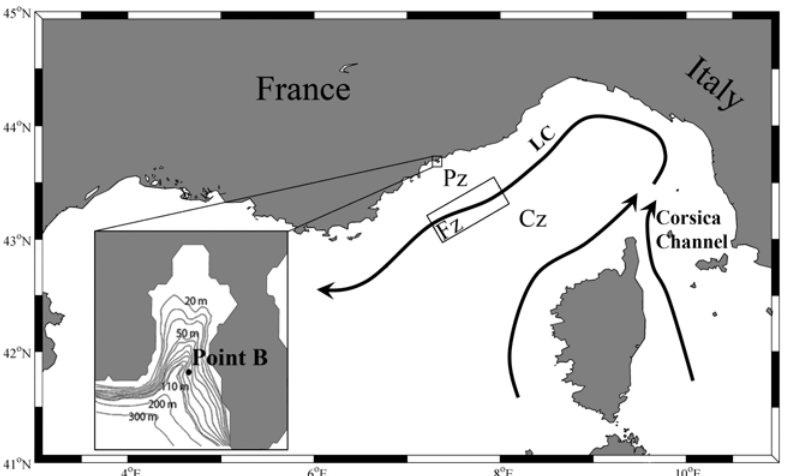
Fig 1. Map of the study area showing the general circulation in the Ligurian basin (black arrows). The peripheral zone (Pz), the frontal zone (Fz), schematized as a box superimposed on the top black arrow, and the central zone (Cz) are represented. LC stands for Ligurian Current. Bathymetric map of the Bay of Villefranche with the sampling station Point B (43°41.10 N, 7°19.00